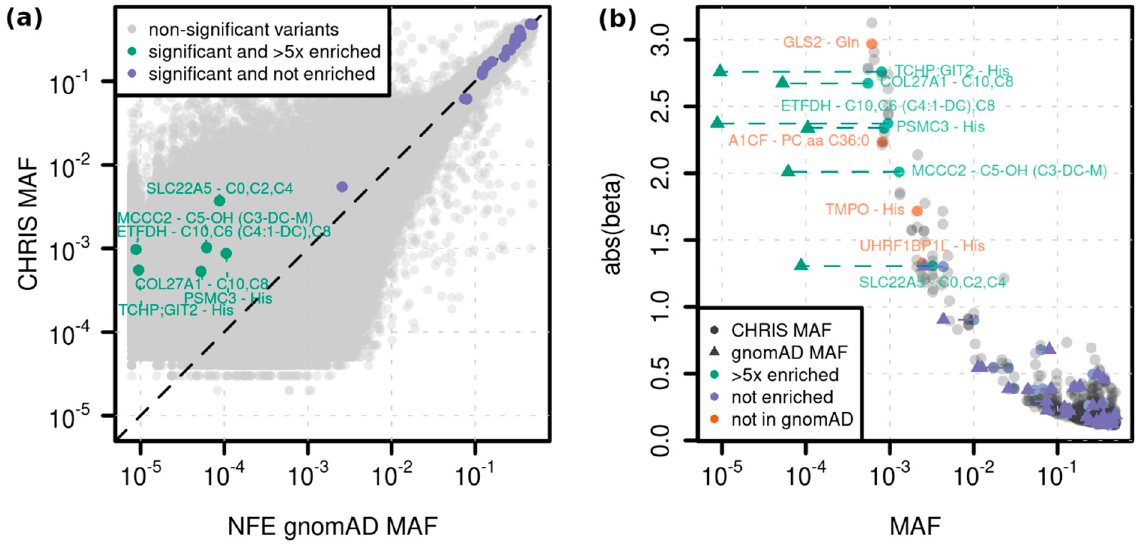
Figure 3. Variant enrichment in CHRIS compared to gnomAD. ( a ) Minor allele frequency (MAF) of matching variants in CHRIS and gnomAD for variants with a minor allele count greater zero in both cohorts are plotted in grey. For gnomAD the non-Finnish European (NFE) MAF is plotted using both exome and genome sequencing data. Variants with conditionally significant annotations in CHRIS are plotted in color, with variants enriched at least five-fold in CHRIS colored in green and labeled with gene—trait(s). ( b ) CHRIS MAF versus the absolute value of beta is plotted as grey points for all significant single variants. The conditionally significant associations listed in Table 1 are colored. For variants that existed in gnomAD, the gnomAD NFE MAF is plotted as triangles in green (>5 times enriched) or purple (<5 times or not enriched) and connected for visibility. For variants that did not exist in gnomAD or had an allele count of zero, only the CHRIS MAF is plotted in orange. Associations from Table 1 with an absolute beta value greater than one are annotated with gene—trait(s).